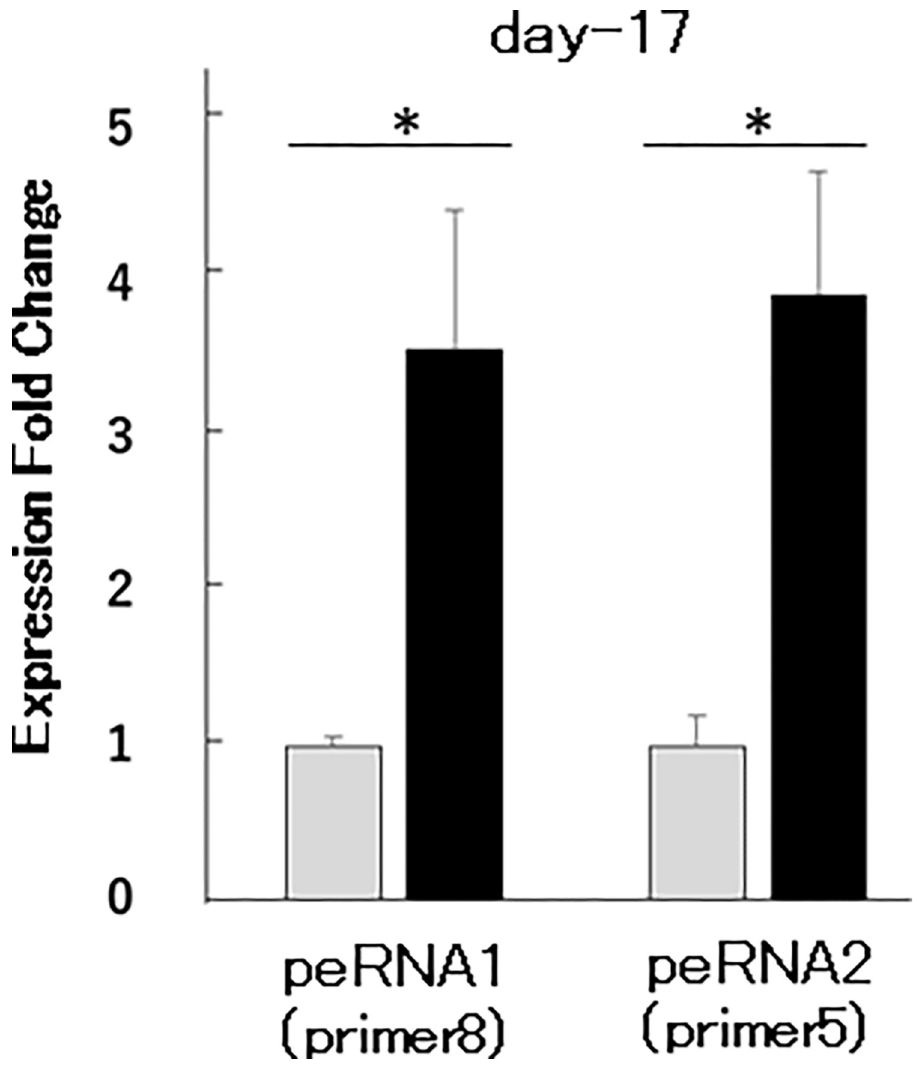
Fig 5. Expression pattern of peRNA1 and peRNA2 in mice vagina at day-17. Expression fold change of peRNA1 (primer 8) and peRNA2 (primer 5) between neoOil (gray) and neoDES (black) (n = 3; t-test, � p < 0.05).